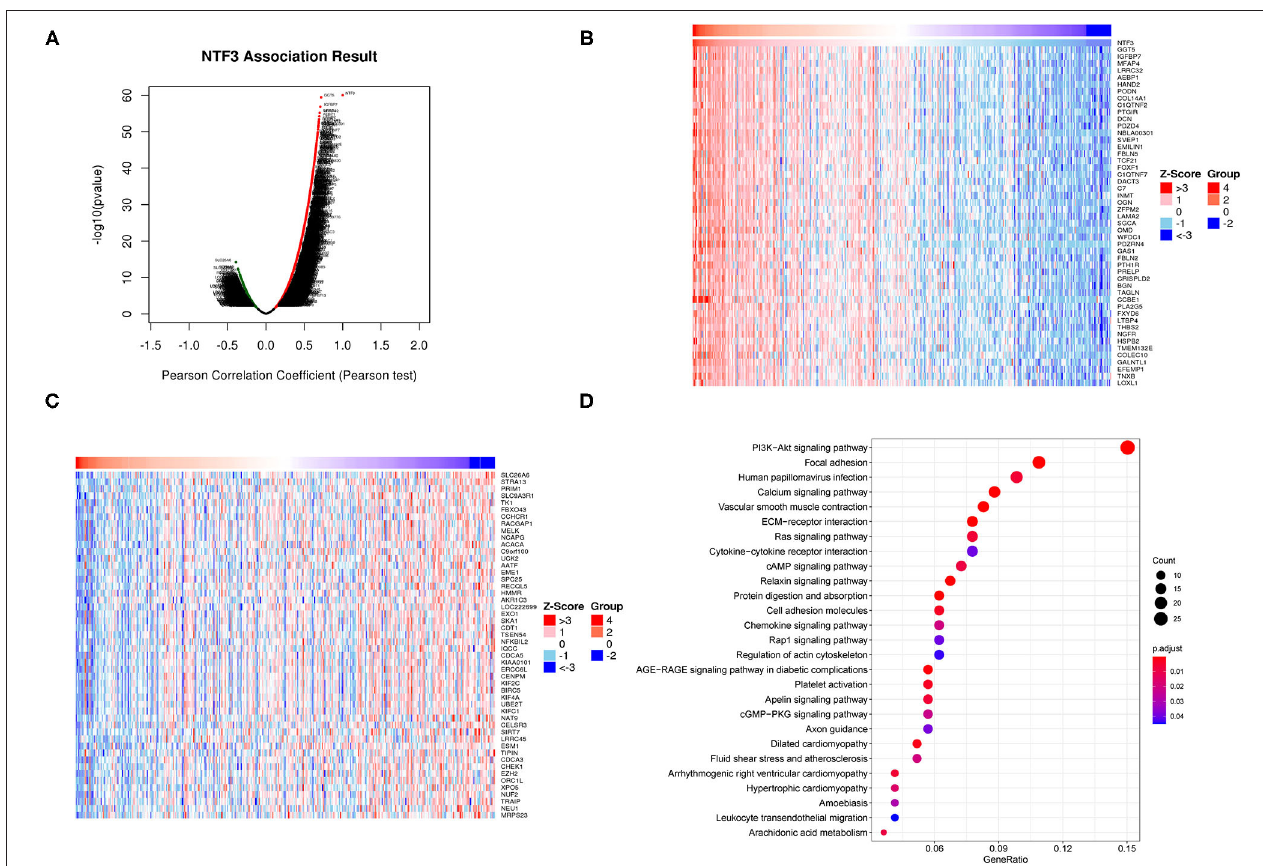
FIGURE 6 | NTF3 co-expressed genes and functional enrichment (LinkedOmics). (A) Volcano map shows differentially expressed genes related to NTF3 in liver cancer. (B) The heat map shows the top 50 genes positively related to NTF3. (B) The heat map shows the top 50 genes positively related to NTF3. (C) The heat map shows the top 50 genes negatively related to NTF3. (D) KEGG enrichment analysis by genes co-expressed with NTF3.